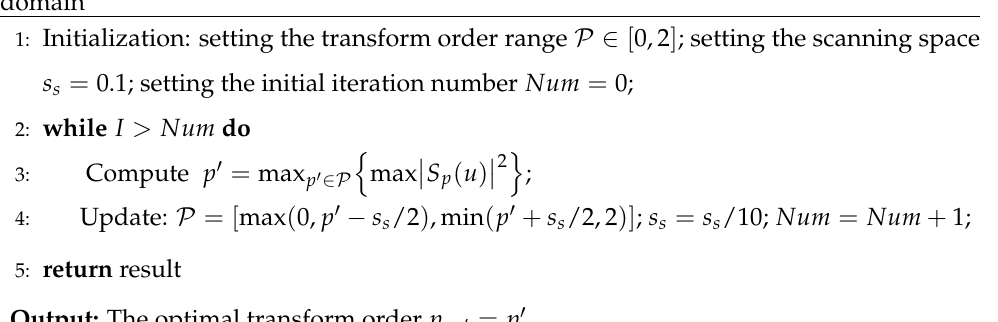
Algorithm 1 The optimal transform order corresponding to the maximum value in FrFT domain